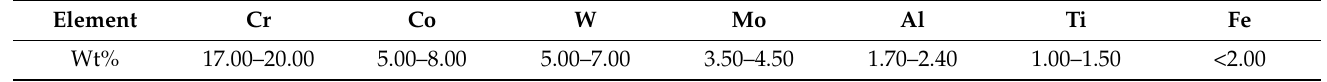
Table 2. The nominal composition of GH4099.